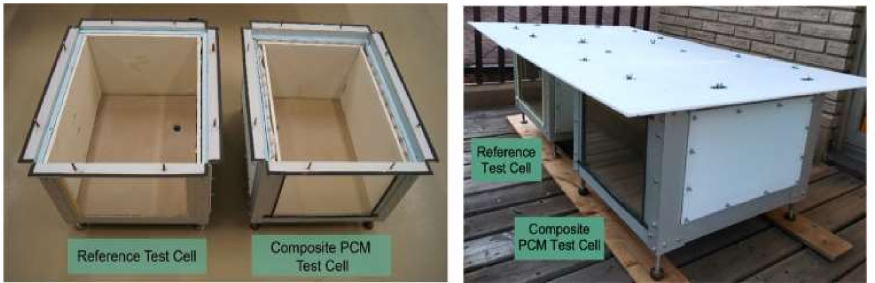
Figure 1. Experimental unit in the study of